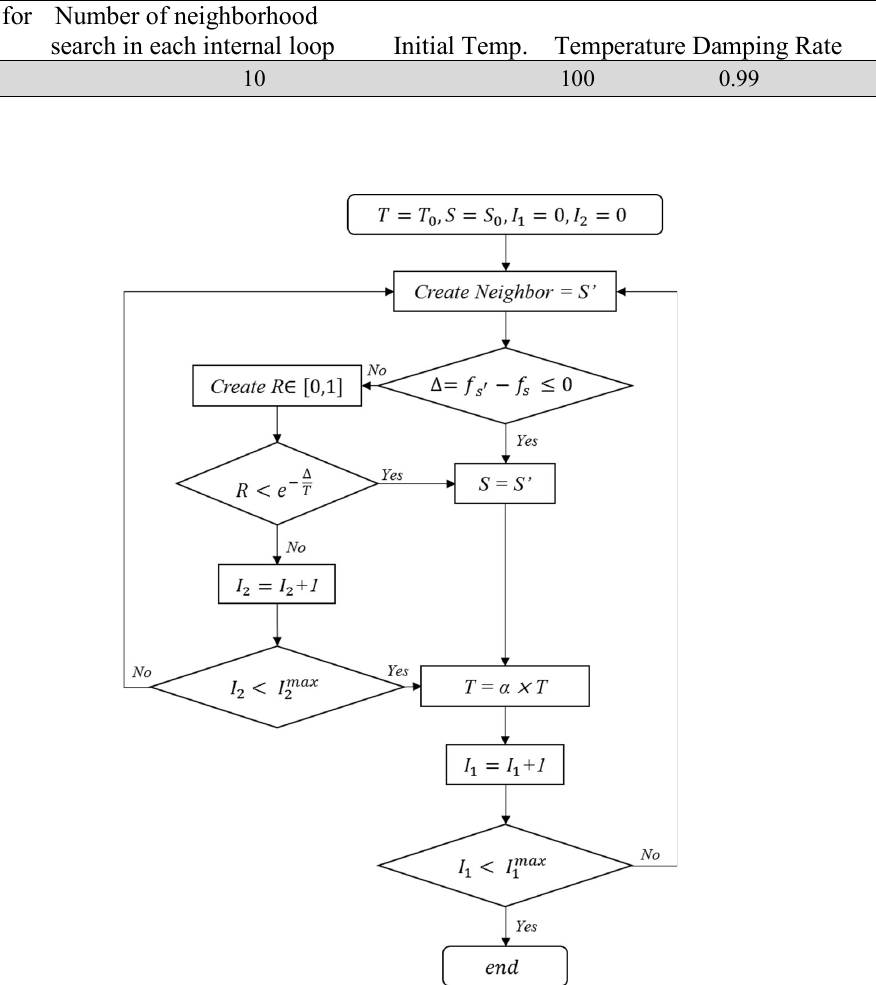
SA parameters Max iteration for Number of neighborhood algorithm search in each internal loop Initial